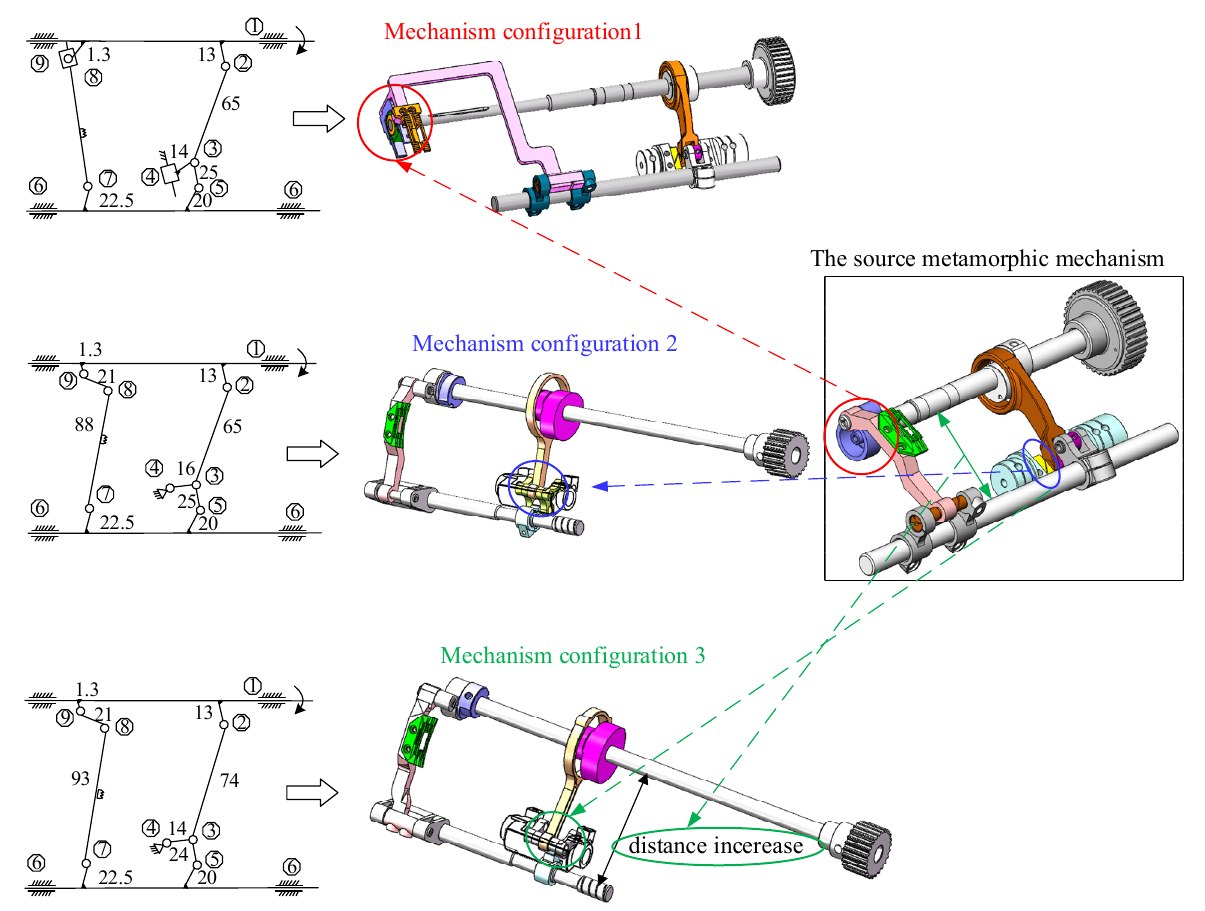
Figure 12. Mechanism configurations of the feed mechanism.